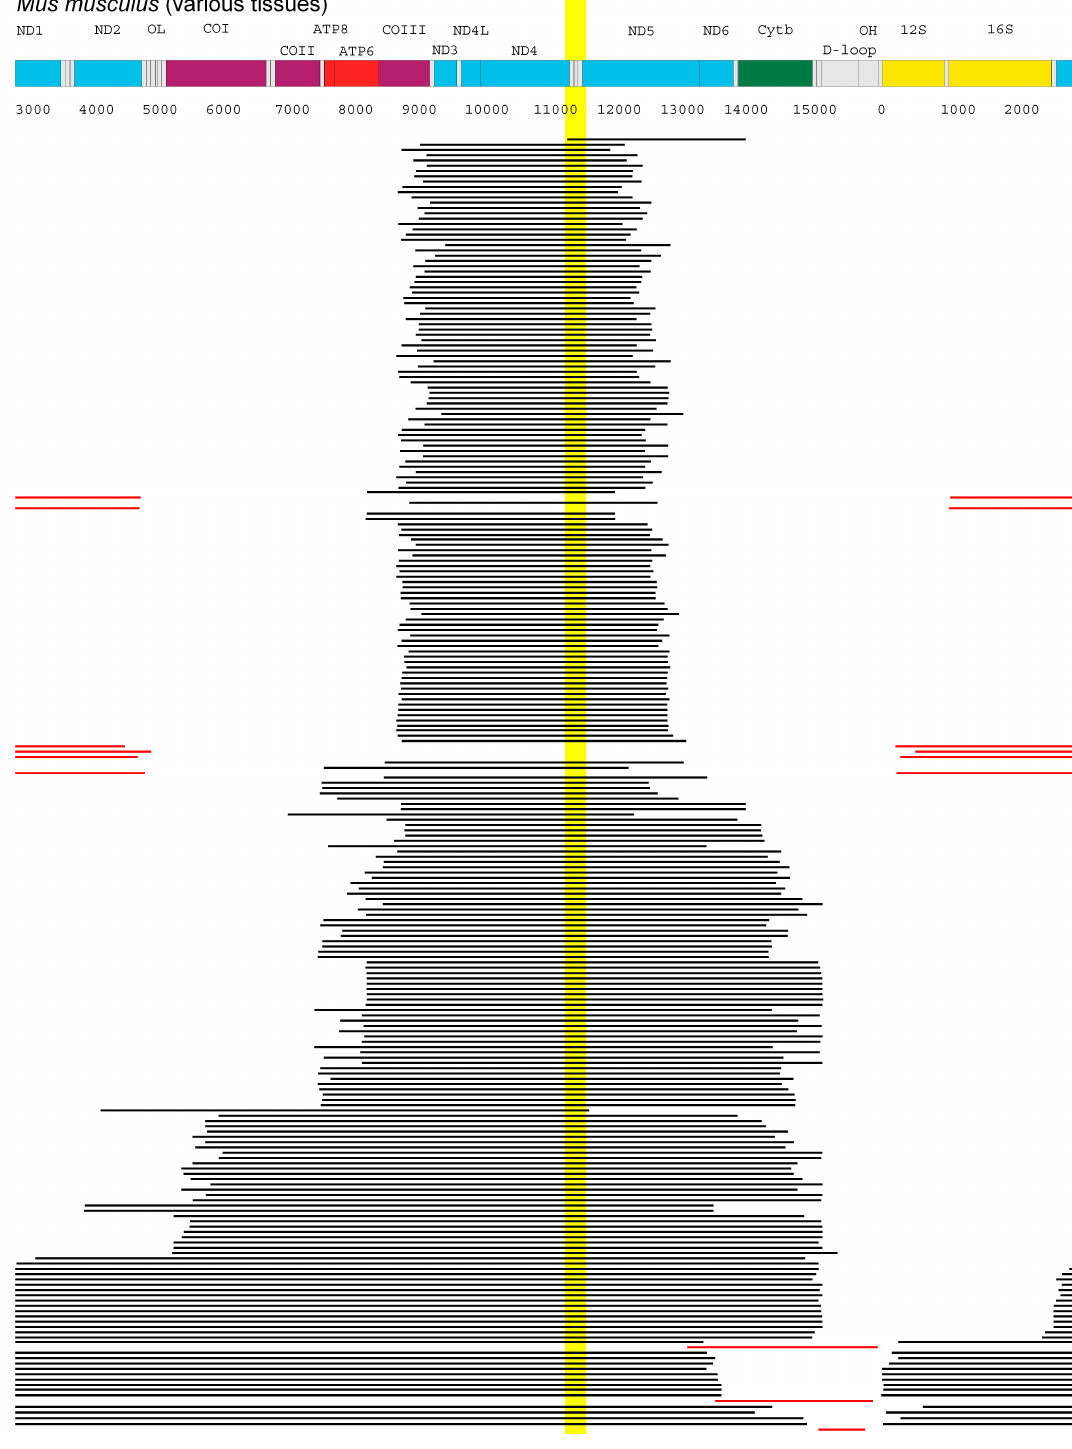
Figure 3. Deletion spectrum of mtDNA deletions found in mice, taken from the MitoBreak database [25]. The data come from 24 publications that studied various tissues using different techniques. The highlighted area indicates a stretch of mtDNA deleted in a total of 236 of the 245 mice samples around the nicotinamide adenine dinucleotide dehydrogenase (NADH) subunit 4 gene ( ND4 ) and ND5 genes. The remaining nine deletions are shown in red.